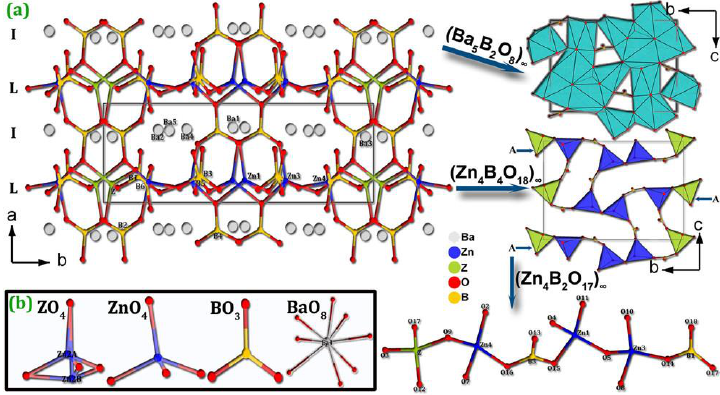
Figure 11. ( a ) The crystal structure of Ba 5 Zn 4 (BO 3 ) 6 ; ( b ) Basic building blocks in Ba 5 Zn 4 (BO 3 ) 6 . Reprinted with permission from Ref. [62], Copyright (2017) American Chemical Society.